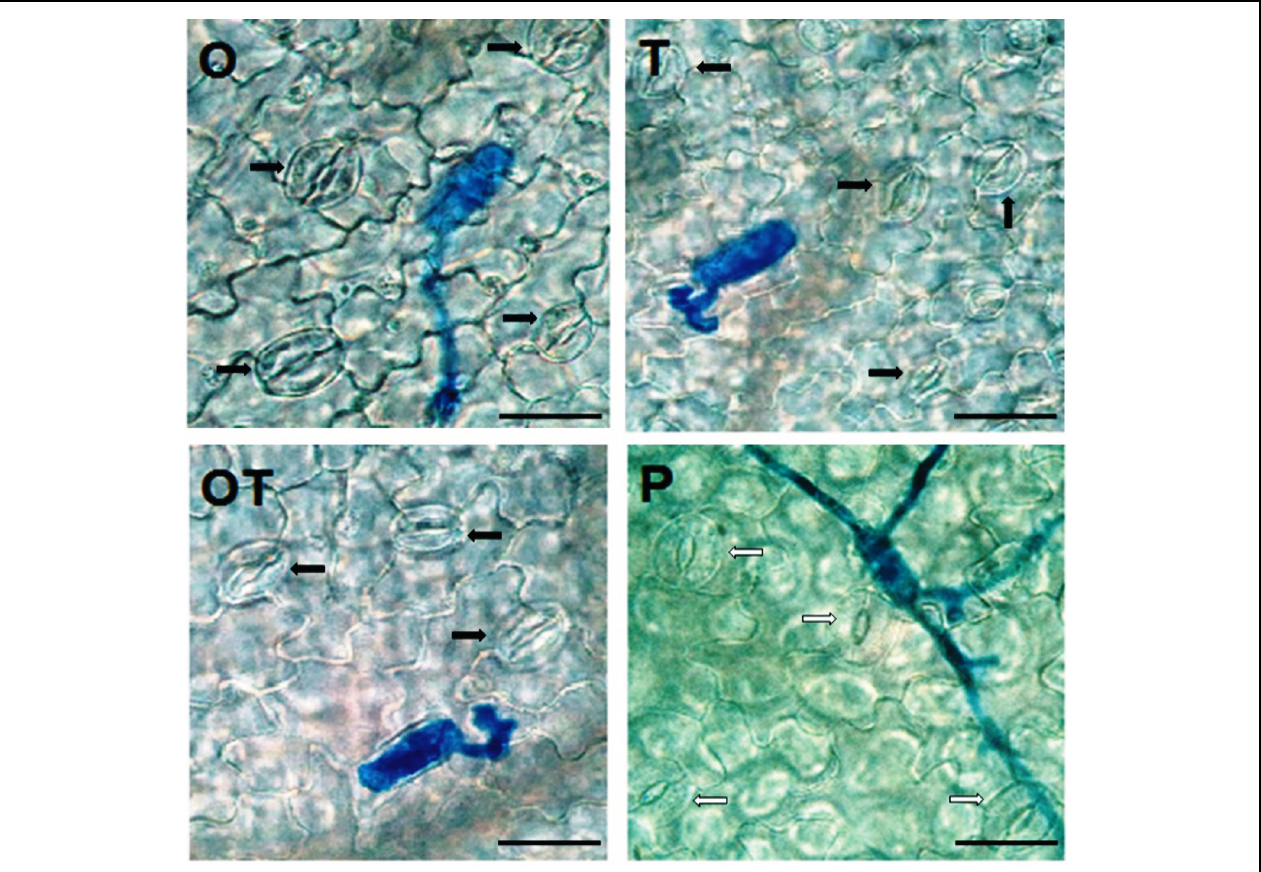
FIGURE 5 | Stomata behavior in pea leaves after 24 h of pathogen ( E. pisi ) challenge in different treatments: P- Pathogen E. pisi , O- P. fluorescens OKC, T - T. asperellum T42, OT- combination of OKC and T42. Stomata of pea leaves were open in treatments P and O, nearly closed in T and closed in OT. White arrows indicate open stomata and black arrows indicate closed stomata. The bars are equivalent to 100 μ